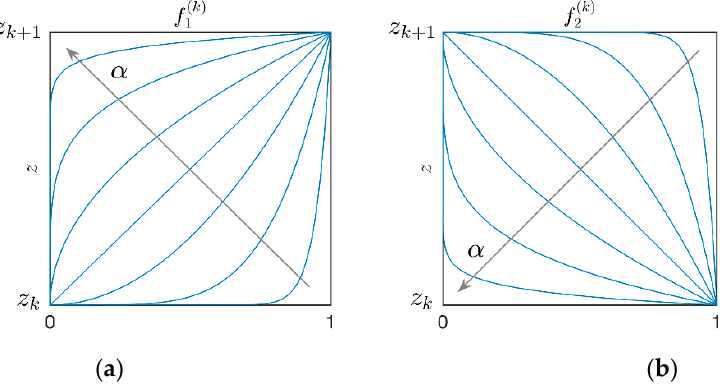
( ) k f employed to characterize the